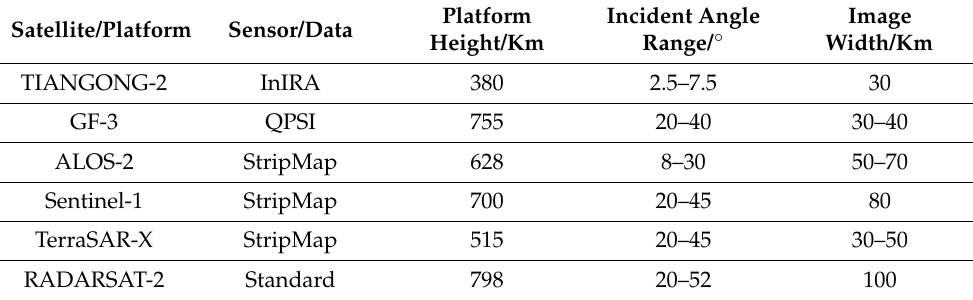
Table 2. Setting the parameters of the imaging